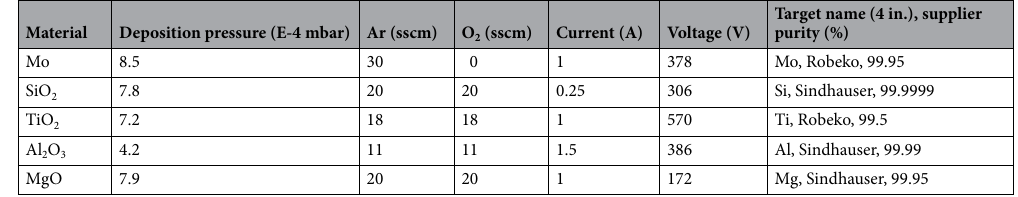
Table 1. Overview of the used sputtering